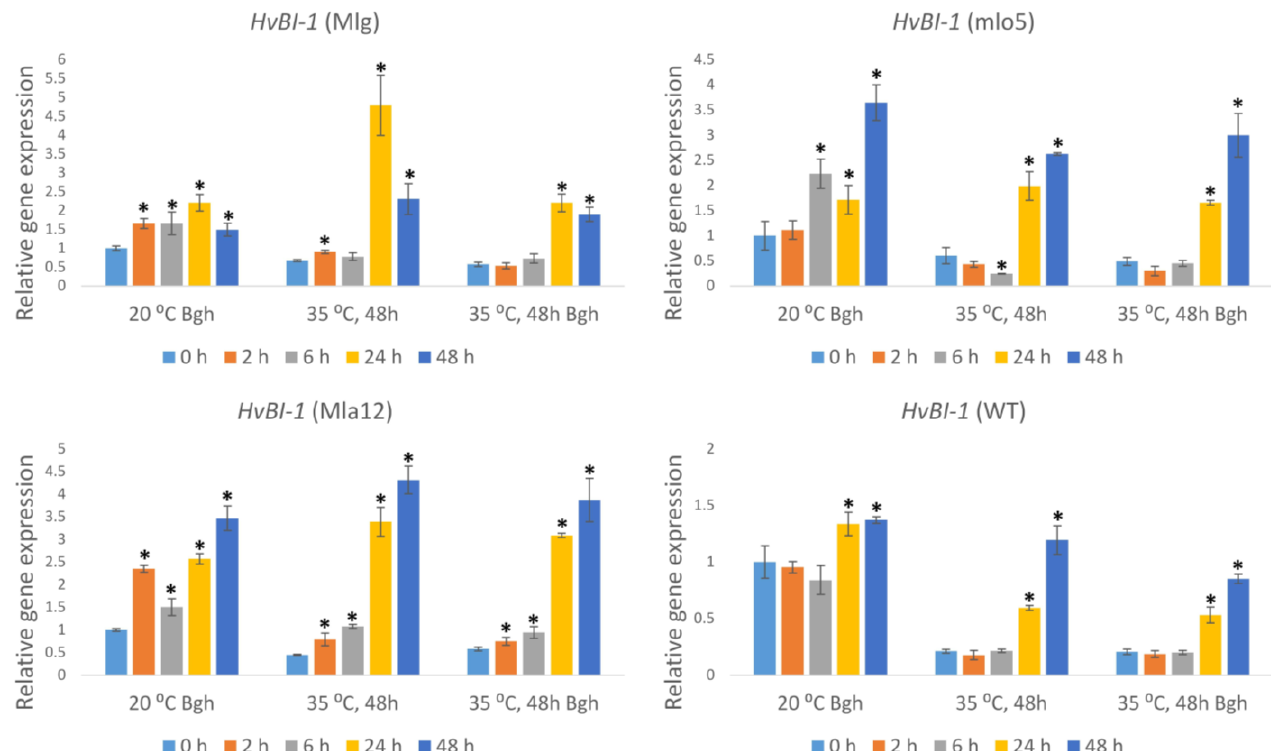
Figure 7. Expression of the barley Bax inhibitor-1 ( HvBI-1 ) gene as detected by RT-qPCR in resistant (Mlg, mlo5, Mla12) and susceptible (WT) Hordeum vulgare cv. Ingrid near-isogenic lines at early time points (0 h, 2 h, 6 h, 24 h, and 48 h) following powdery mildew ( Blumeria graminis f. sp. hordei A6, Bgh) inoculation and/or heat stress. Heat stress treatments at 35 °C for 48 h were applied immediately before Bgh inoculation. Inoculated but not heat-treated (20 °C Bgh) and heat-treated but not inoculated (35 °C for 48 h) plants were used as controls. The graphs show the average of three experiments. Error bars represent standard deviation. Asterisks ( * ) indicate statistically significant differences from 0 h for each specific treatment at p < 0.05.